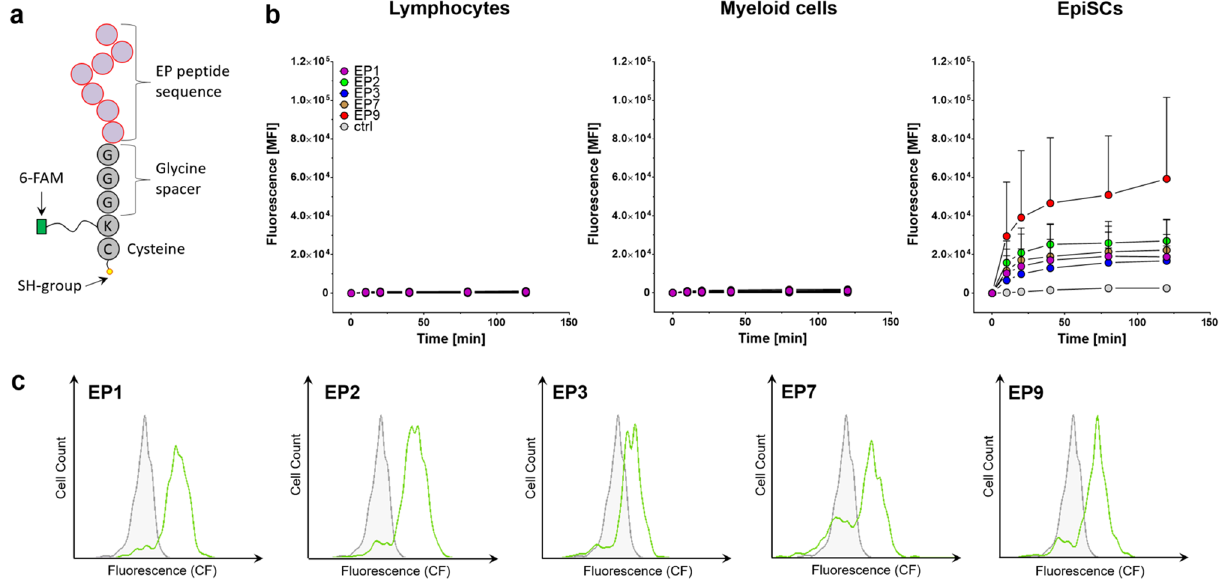
Figure 2. ( a ) Scheme of synthesized EP peptides. The 7-mer peptide sequence is followed by a spacer (GGGK) and a terminal cysteine with a free sulfhydryl group. Carboxyfluorescein (6-FAM) is linked to the ε-amino group of the lysine within the GGGK-spacer, to enable flow cytometry and fluorescence imaging. ( b ) Flow cytometric analysis of the time-course of binding of EPs to cultured EpiSCs (right) and blood-derived myeloid- (middle) and lymphoid (left) immune cells. Data are shown as mean fluorescence intensity ± SD; n = 5. ( c ) EP-binding to freshly isolated EpiSCs. The cell suspension was stained with mAbs against CD45, CD11b and CD73 to identify EpiSCs (CD45− , CD11b−, CD73+ and incubated with either EP1, EP2, EP3, EP7, EP9 or left untreated as control. The histogram plots show an overlay of EP-treated cells (green) and untreated controls (grey). Representative histogram plots of n = 3